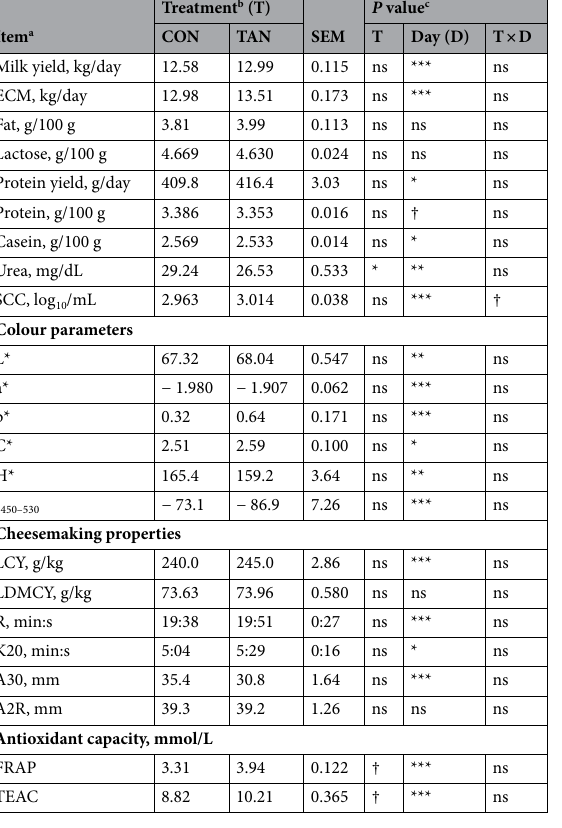
Table 4. Effect of dietary tannin extract on physicochemical properties of milk in dry season experiment. a L* lightness, a* redness, b* yellowness, C* chroma, H* hue angle, I 450–530 integral value of the absorbance spectrum from 450 to 530 nm, LCY laboratory cheese yield, LDMCY laboratory dry matter cheese yield, R clotting time, K20 firming time, A30 curd firmness after 30 min, A2R curd firmness after two times R, FRAP ferric reducing antioxidant power, TEAC Trolox-equivalent antioxidant capacity, ECM energy corrected milk, SCC somatic cells count. b CON control group, TAN group receiving 150 g/head × day of tannin extract. c ns ≥ 0.100; † <